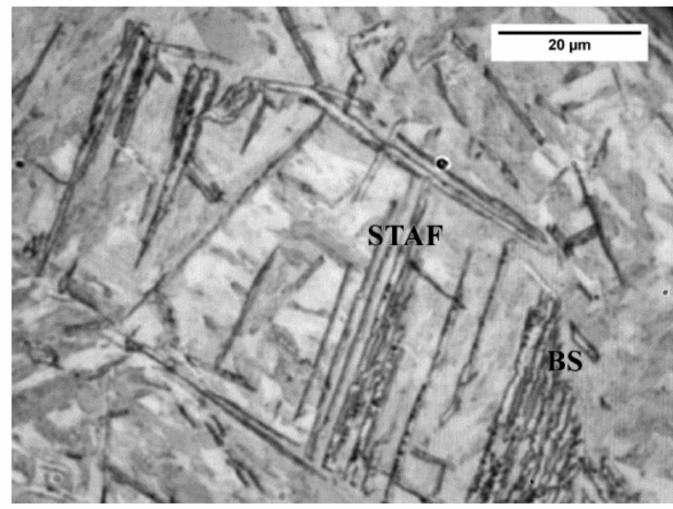
Figure 3. Micrograph of the sample held at 400 ◦ C for 20 s. Light microscopy.